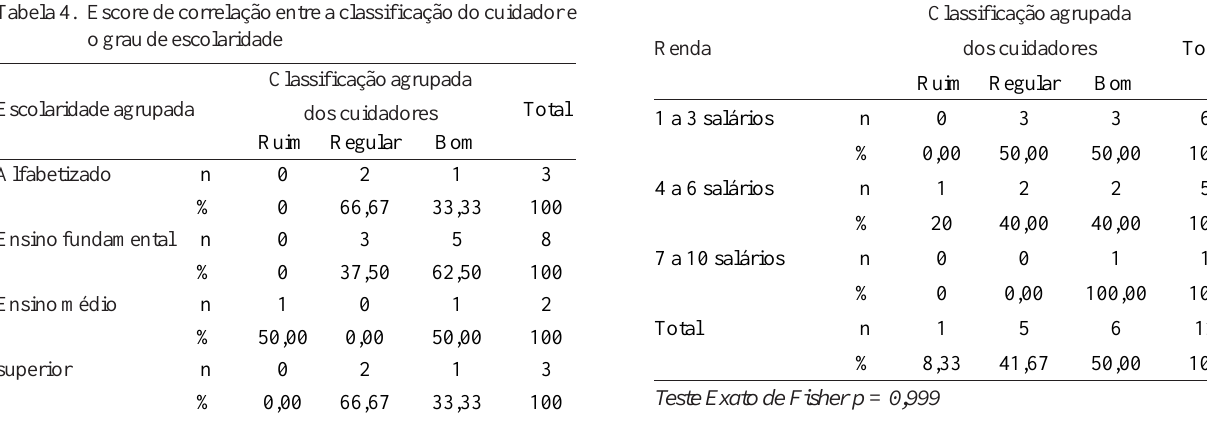
Tabela 4. Escore de correlação entre a classificação do cuidador